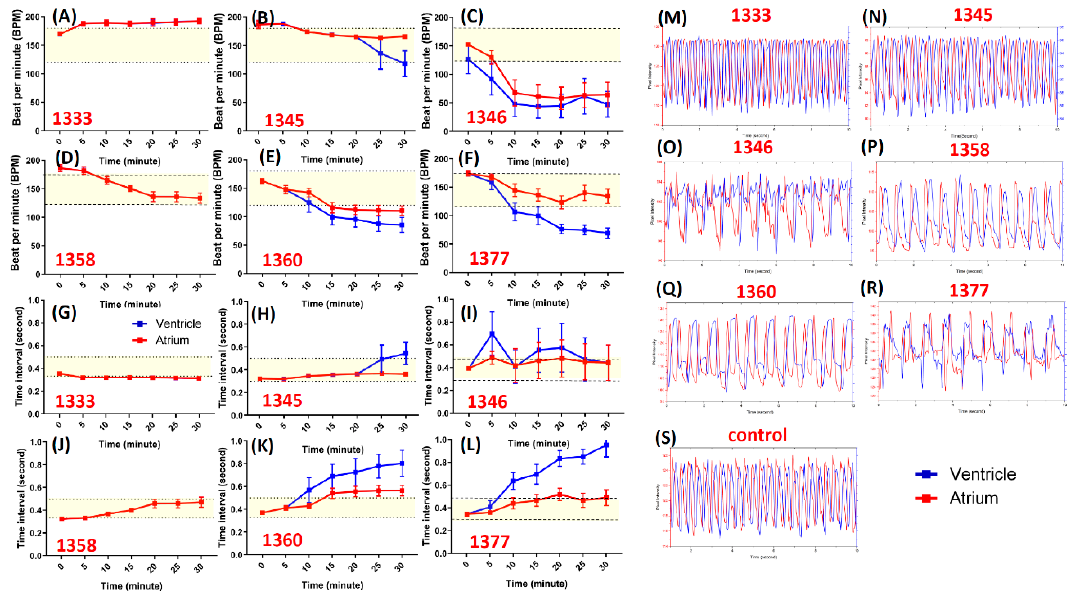
Figure 3. The chronology screen result for ion channel ligand library by using zebrafish embryos aged 72 hpf. ( A ) Atrium (red color) and ventricle (blue color) beat per minute (BPM) and ( G ) beat time interval for compound 1333 screened. ( B ) BPM and ( H ) Beat time interval for compound 1345 screened. ( C ) BPM and ( I ) Beat time interval for compound 1346 screened. ( D ) BPM and ( J ) Beat time interval for compound 1358 screened. ( E ) BPM and ( K ) Beat time interval for compound 1360 screened. ( F ) BPM and ( L ) Beat time interval for compound 1377. ( M – S ) Atrium and ventricle rhythmicity pattern after 30 min incubation of compounds number 1333 (Antibiotic A-23187), 1345 (Flunarizine hydrochloride), 1346 (FPL-64176), 1358 (Niguldipine-HCl), 1360 (Pimozide), 1377 (Fluspirilene), and control.